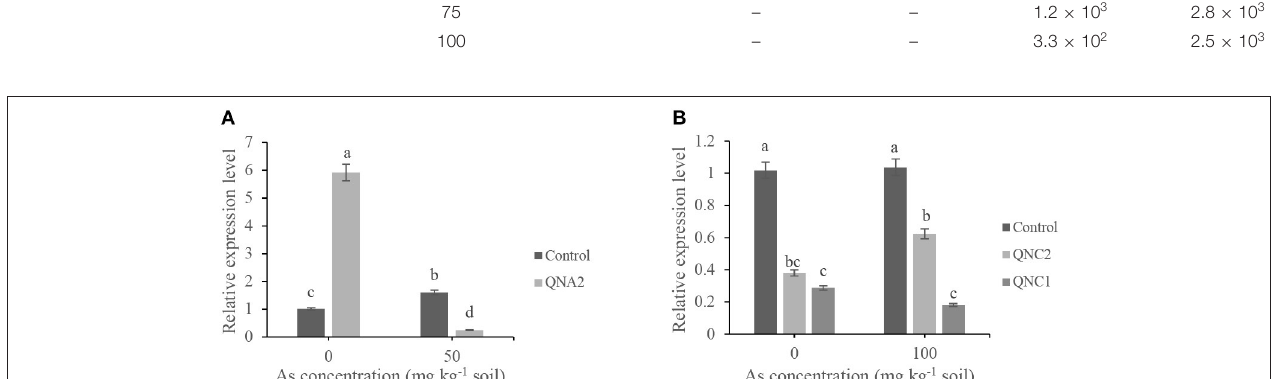
FIGURE 6 | Relative expression levels of the NPR3 gene in the roots of (A) non-treated alfalfa plants (control) and plants treated by Acinetobacter sp. QNA2, (B) non-treated chickpea plants (control), and plants treated by Pseudomonas sp. QNC1 and Rahnella sp. QNC2. The results represent the means of three replicates. Vertical bars indicate standard errors (SE), and different letters indicate statistically significant differences between treatments at probability levels of 5%.